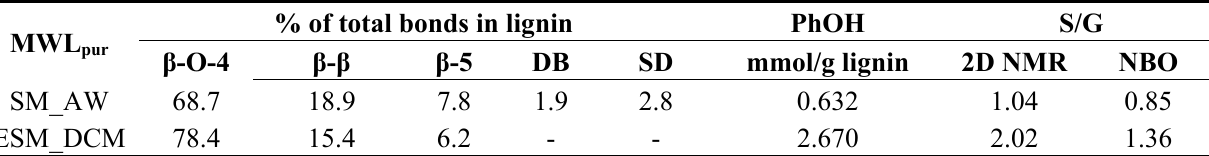
Table 4. Results of compositional analysis of MWL main lignin bonds and S/G), nitrobenzene oxidation (S/G) and periodate oxidation (PhOH). NMR: nuclear magnetic resonance spectroscopy; and NBO: nitrobenzene